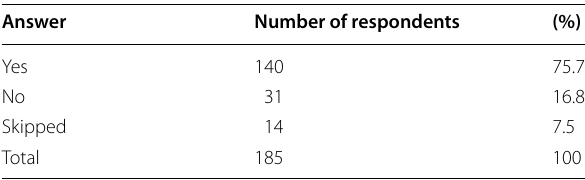
Table 5 Experience of 185 respondents with AI-based algorithms for clinical diagnostic interpretive tasks: Were the findings of the algorithm(s) considered to be